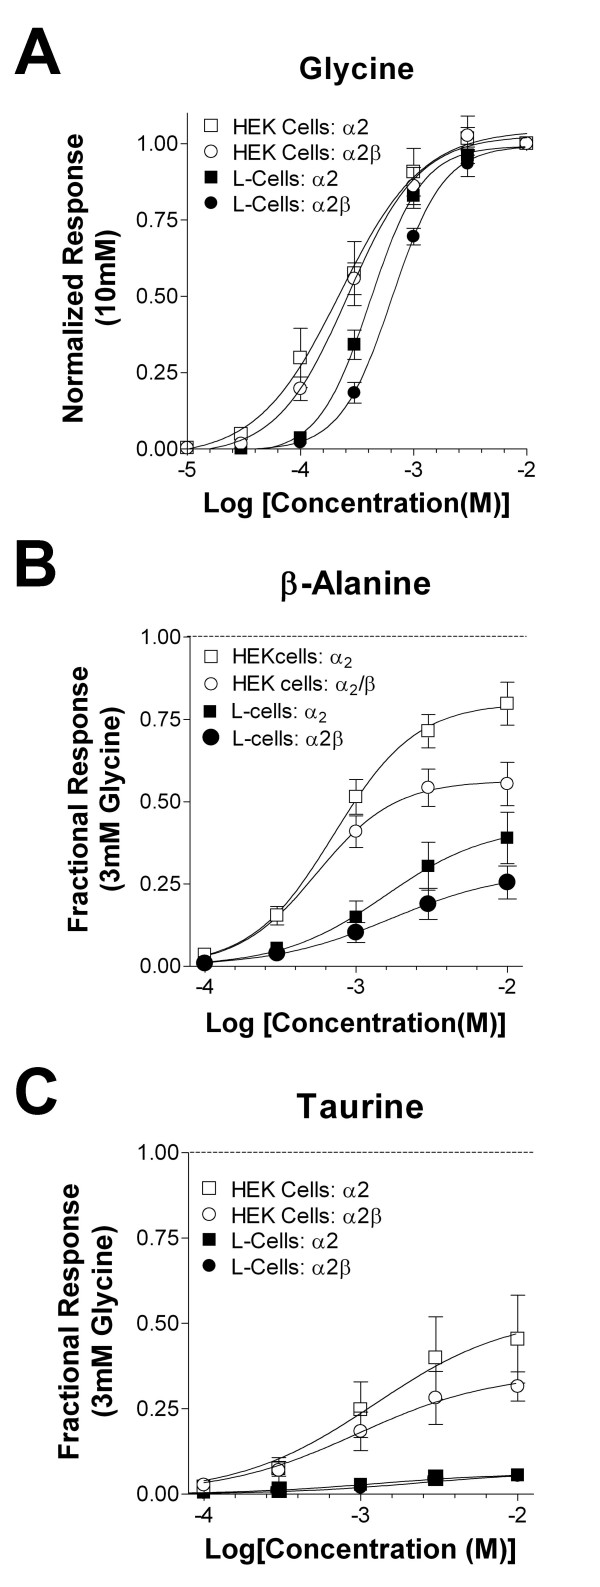
Glycine receptors expressed show expression-system dependent agonist pharmacology. (A) Glycine has a reduced potency in L-cells compared to HEK cells. Glycine current responses were plotted versus the log concentration of glycine and normalized to a maximal concentration of glycine (3–10 mM). Data are presented as mean ± SEM; 4 ≤ n ≤ 9 cells for each concentration. Concentration response relationships for GlyRα2 (□; EC50 = 221 μM) and GlyRα2β (○; 269 μM) in HEK cells and in L-cells (GlyRα2, ■, 446 μM; GlyRα2β, ●; 667 μM) were derived from logistic equation fits to individual cells. (B) β-alanine has both reduced apparent affinity and efficacy for most glycine receptor isoforms transiently expressed in L-cells compared to HEK 293 cells. β-alanine apparent potency in HEK 293 cells was 717 μM for GlyRα2 (□, n = 6) and 560 μM for GlyRα2β (○, n = 7). For L-cells, β-alanine potency for GlyRα2 (■, n = 5–8) was 1.61 mM and 1.79 mM for GlyRα2β (●, n = 7). Current responses were normalized to a maximal concentration of glycine (10 mM). Note the reduced apparent efficacy of α2β receptors compared to the α2 homomeric isoforms. (C) Taurine has both reduced apparent affinity and efficacy to GlyRs transiently expressed in L-cells compared to HEK 293 cells. Taurine concentration-response relationship in HEK 293 for GlyRα2 (□; 442 μM, n = 5–6) and GlyRα2β (○; 1.25 mM, n = 3–5). Taurine concentration-response relationship in L-cells yielded GlyRα2 (■, n = 4) and GlyRα2β (●, n = 7) potencies estimated at ≥ 3 mM. Current responses were plotted versus the log concentration of taurine and normalized to a maximal concentration of glycine.